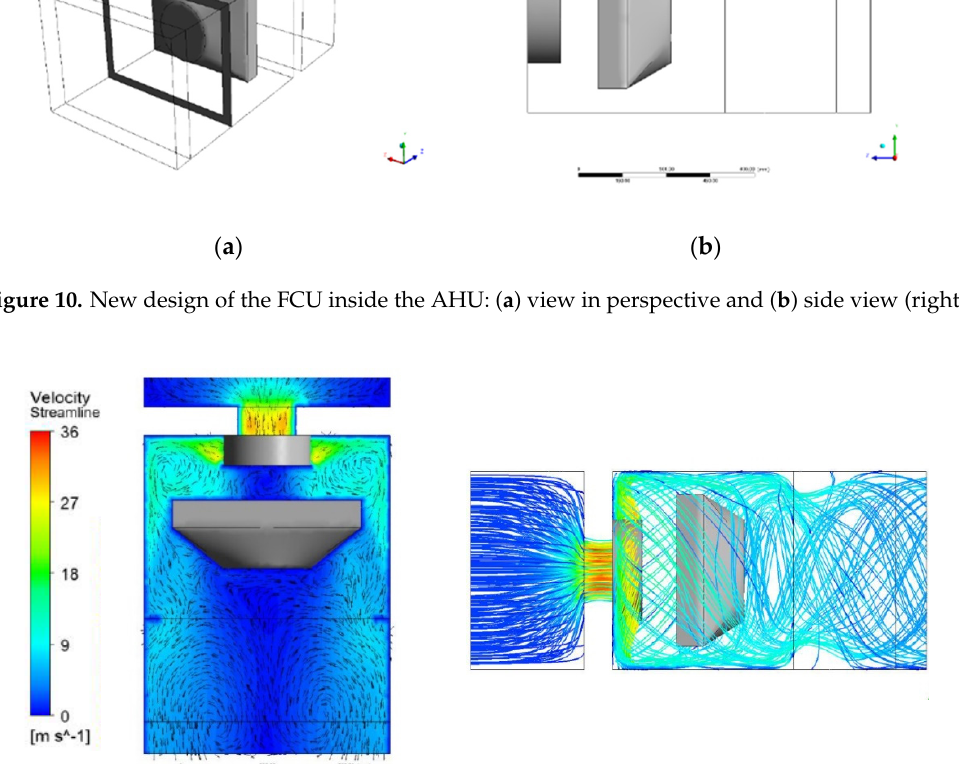
Figure 10. New design of the FCU inside the AHU: ( a ) view in perspective and ( b ) side view (right).